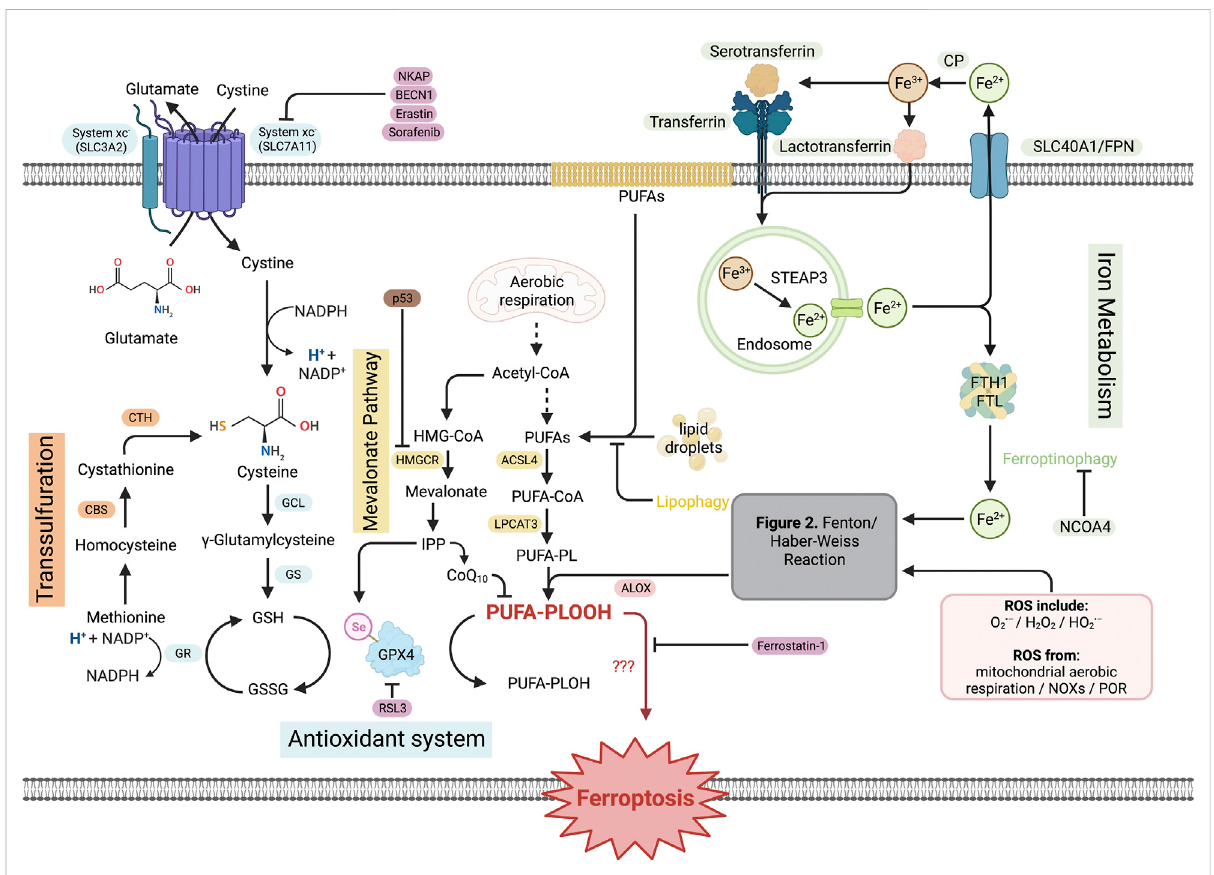
FIGURE 2 Pathways of ferroptosis. The entirety of ferroptosis signaling is complex and orchestrated by different sub-pathways, along with a multitude of regulatory proteins or substances. The antioxidant system starts with system xc − activity that assists the exchange of cystine and glutamate. Intracellular cystine is converted, in multi-step reactions, to GSH. The transsulfuration reaction starts with conversion of intracellular methionine to cysteineandjoinstheantioxidantsystemtoenhanceGSHproduction.LipidROSproductionfrommembranePUFAs,intracellularlipiddroplets, and acetyl-CoA resulted from mitochondrial aerobic respiration, which is negatively regulated by lipophagy, provides predominant lipid source to produce lipid ROS by joining the Fenton/Haber – Weiss reaction. Iron metabolism starts with Fe 3+ endocytosis initiated by a transferrin receptor, and STEAP3-mediated reduction to Fe 2+ takes place in endosome. Fe 2+ joins LIP by FTH1/FTL. Ferritinophagy triggers the release of Fe 2+ to join intracellularROSpoolandproceedstotheFenton/Haber – WeissreactiontoproducelipidROS.Takentogether,thePUFA-PLOOHresultingfromthe reactions induces ferroptotic damage with the mechanism that lacks exactitude. Created with